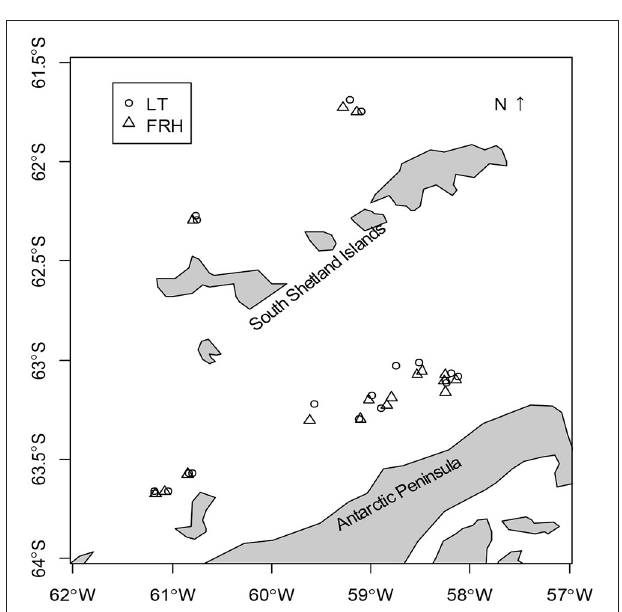
FIGURE 1 | Fishing sites of LT (circle) and FRH (triangle) of matched